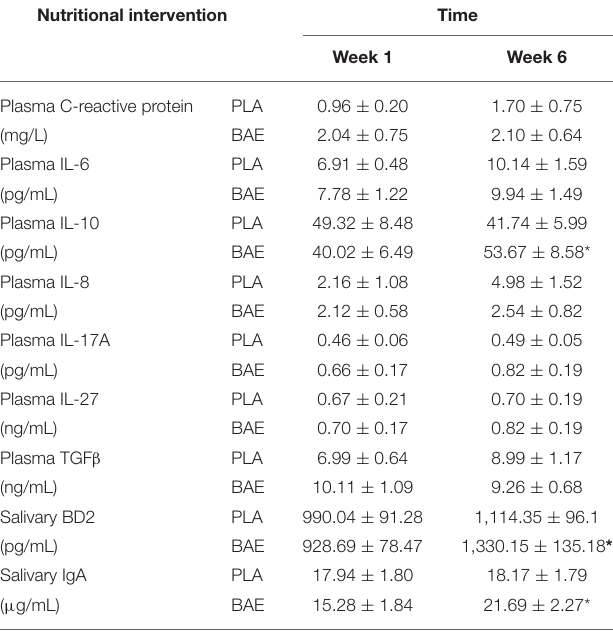
TABLE 1 | Inflammatory mediators were measured on week 1 and 6 after daily consumption of either New Zealand blackcurrant anthocyanin-rich extract (BAE) or placebo (PLA) for 5